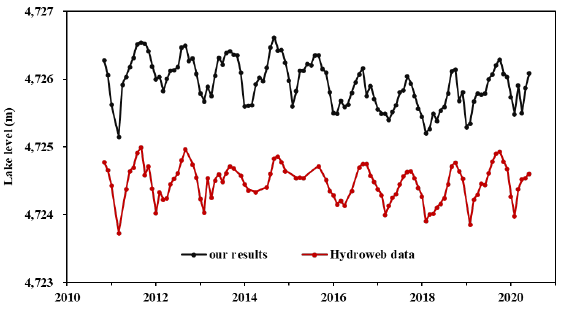
Figure 4 . Comparison of lake levels derived from CryoSat-2 (black) and Hydroweb